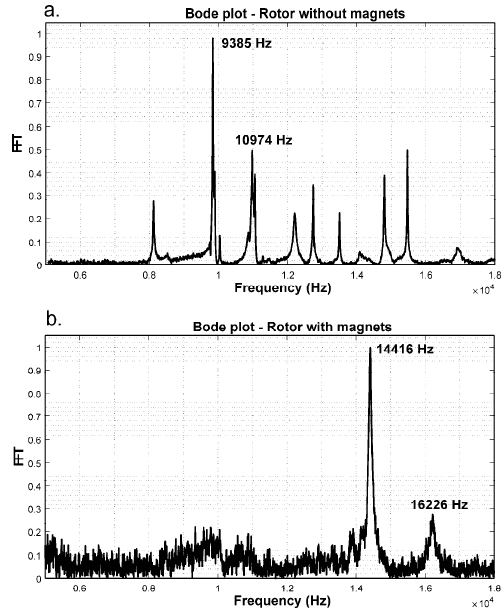
Figure 12. The results of the experimental modal analysis: ( a ) rotor without magnets and ( b ) rotor with magnets.